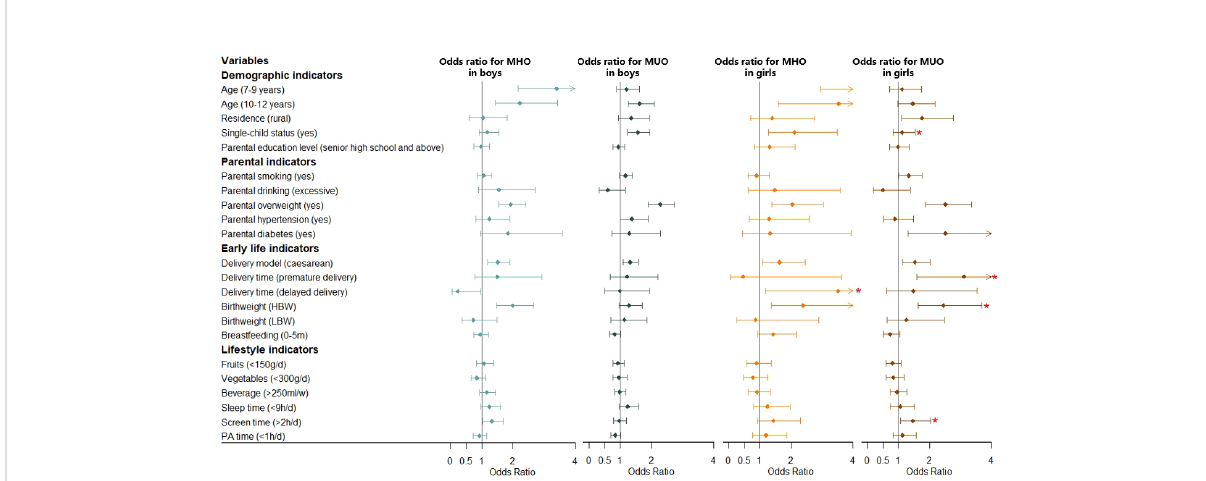
FIGURE 2 Association between MHO/MUO prevalence and risk factors strati fi ed by sex. Obesity phenotypes include metabolically healthy obesity (MHO) and metabolically unhealthy obesity (MUO), taking the participants without MHO or MUO as the reference group. Adjusted for age, residence, single-child status, parental education level, parental smoking, parental drinking, parental overweight, parental hypertension, parental diabetes, delivery model, delivery time, birth weight, breastfeeding, fruits, vegetables, beverage, sleep time, screen time, physical activity (PA) time.